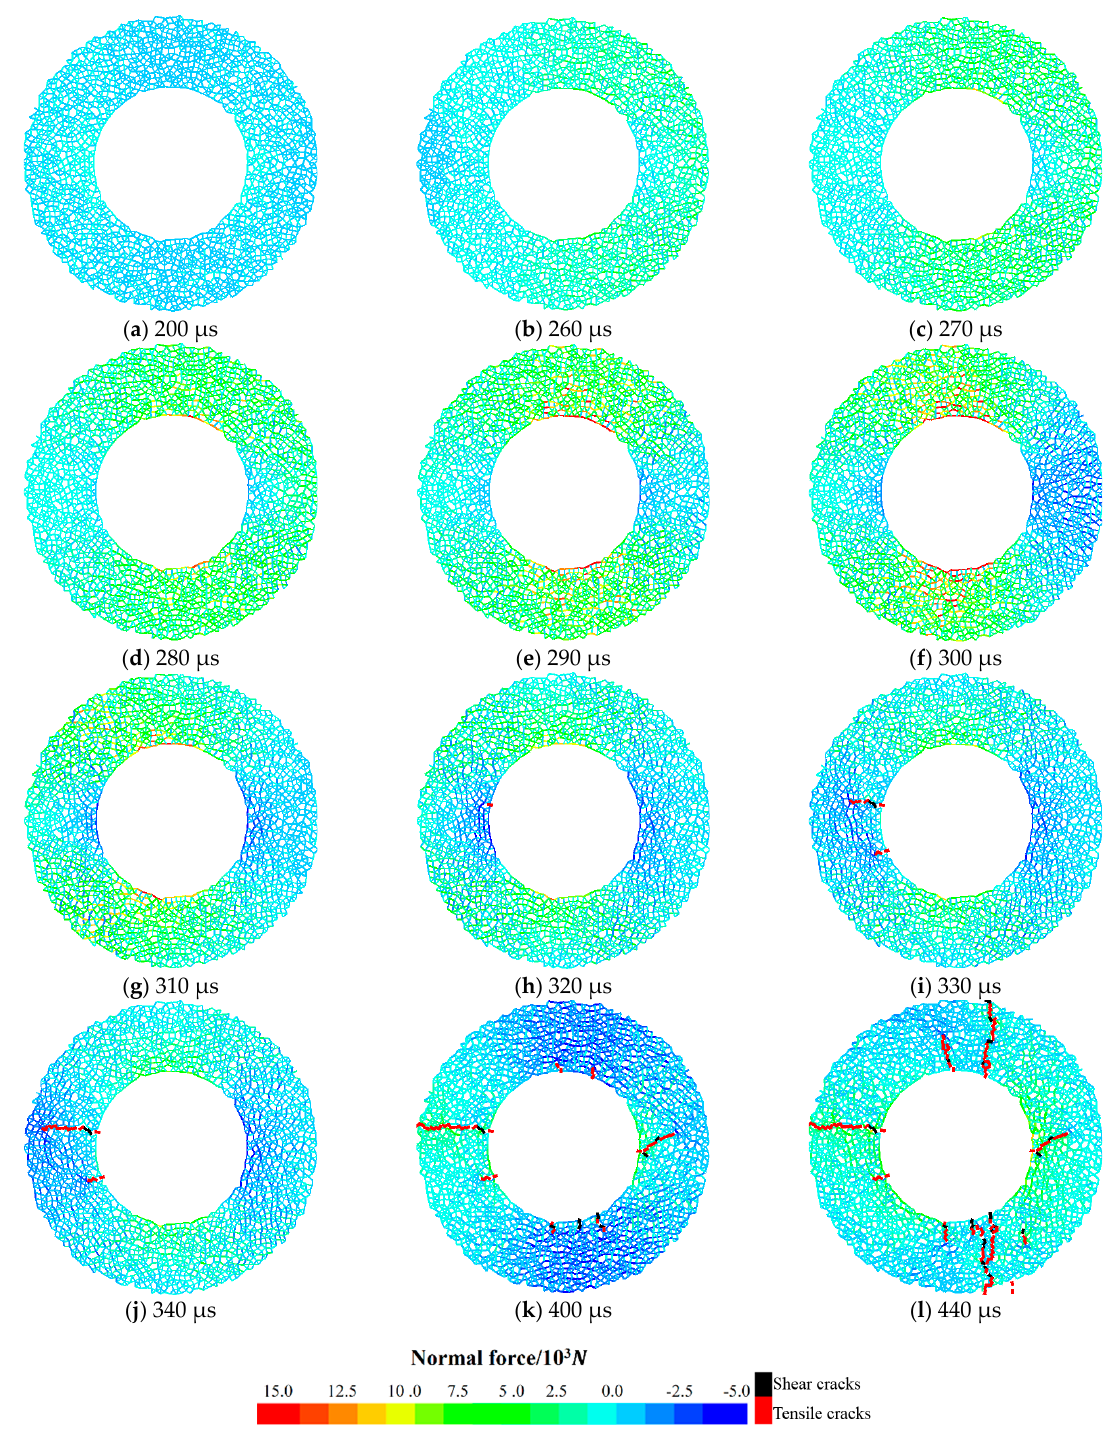
Figure 14. Evolution of normal force chain.